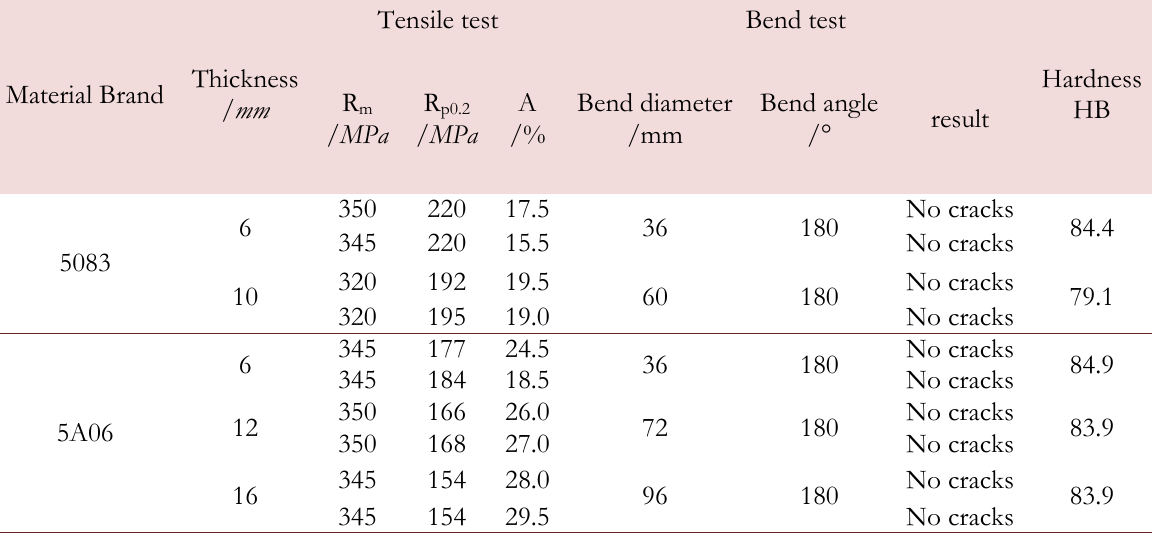
Table 3: Mechanical properties of test materials.